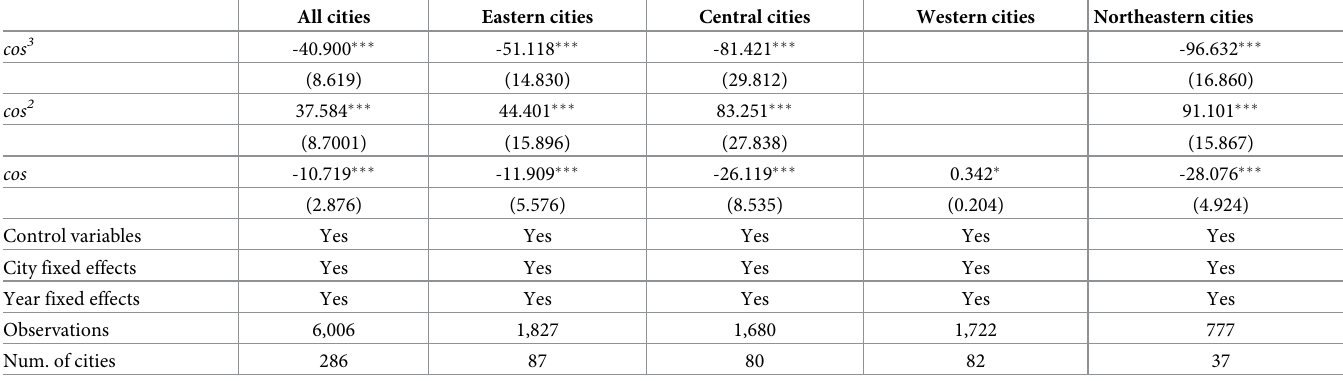
Table 4. Results of Eq (38) (dependent variable: lnrpgdp